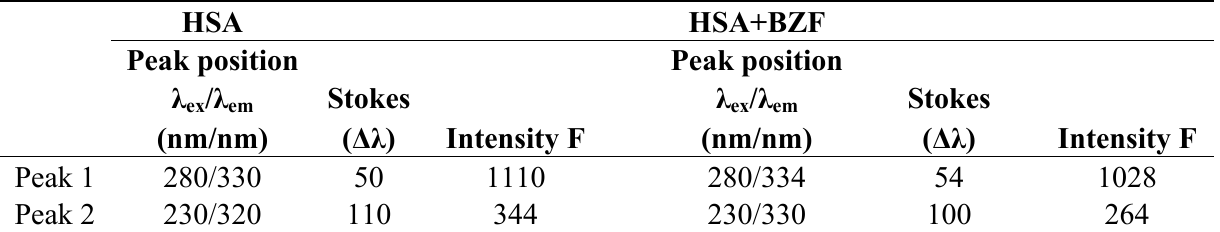
Table 3. Three-dimensional fluorescence spectral characteristics of HSA and HSA-BZF